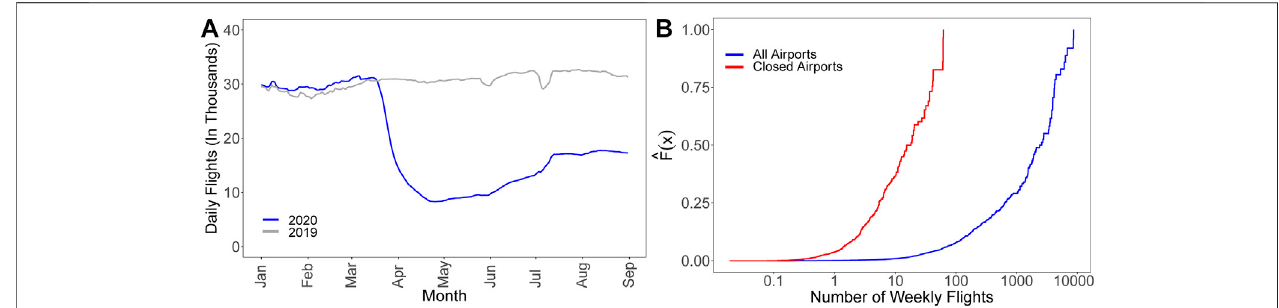
FIGURE 1 | General Network Observations. (A) Seven-day moving averages of number of domestic fl ights by day in 2019 vs. 2020 at 1,200 airports in the ASPM database. (B) Cumulative distribution of average number of domestic fl ights offered per week in 2019 by all United States airports in ASPM database vs. those United Statesairportsthatclosed betweenMay and August 2020. Intotal approximately400airports experienced closurefor at leastone week duringthe studyperiod. Most of these airports are small air fi elds operating predominantly general aviation fl ights, the largest of which offers on average 60 ASPM-reported fl ights during a typical week. Those airports that closed during the study period were inactive for 11 weeks on average, though it should be noted that some of these airports remained closed at the study ’ s termination.